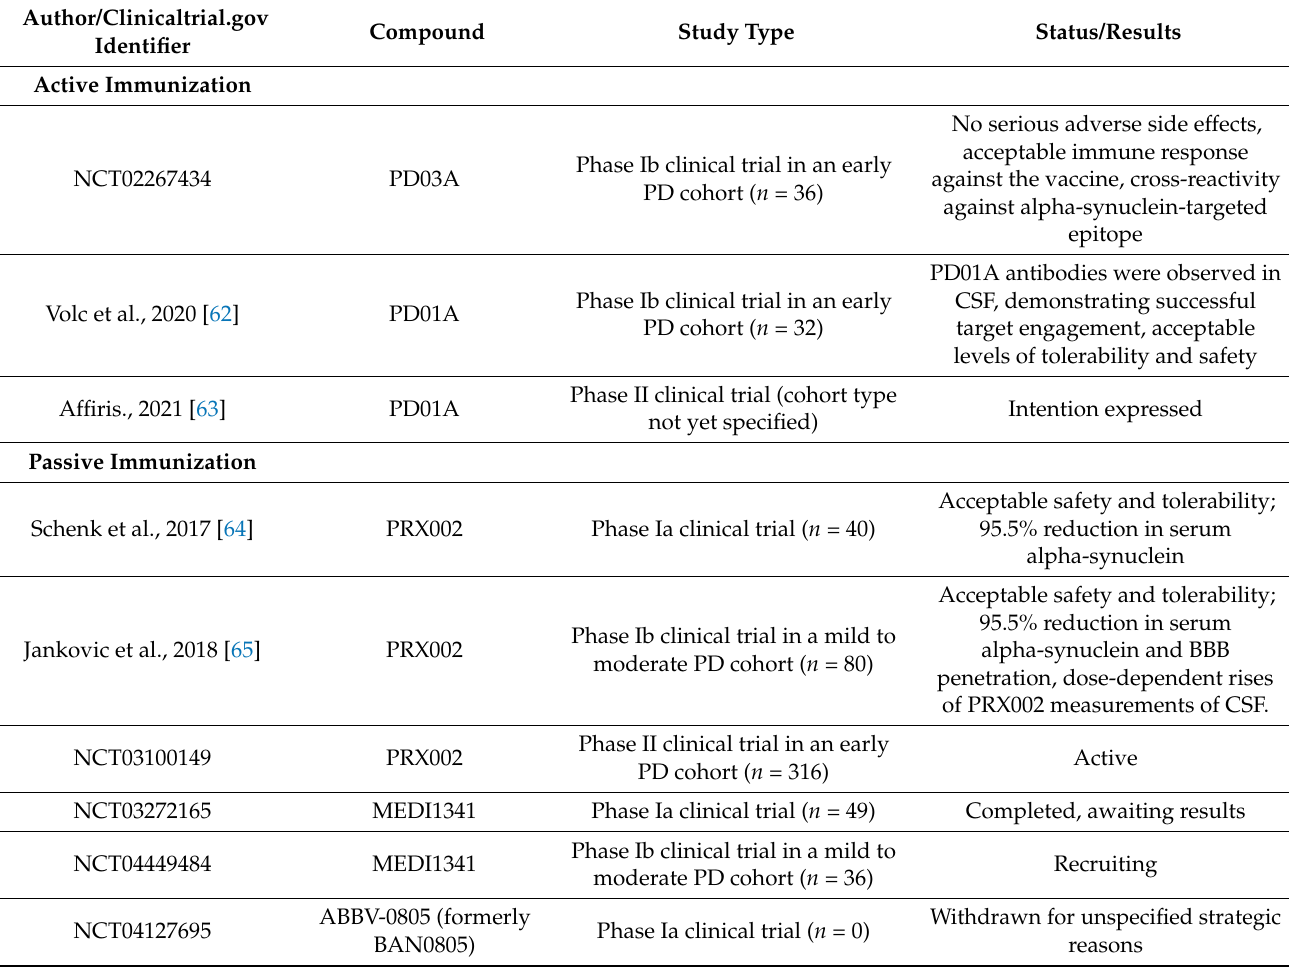
Table 1. A summary of the status/results of previous and ongoing clinical trials involving the immunotherapeutic targeting of extracellular alpha-synuclein